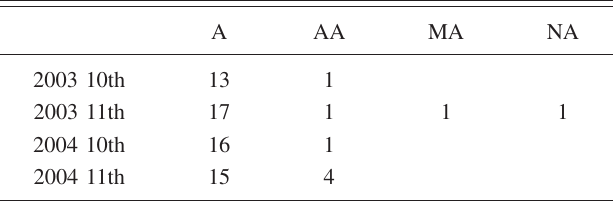
TABLE X. IRT parameter estimates for physics items from the 2004 11th grade